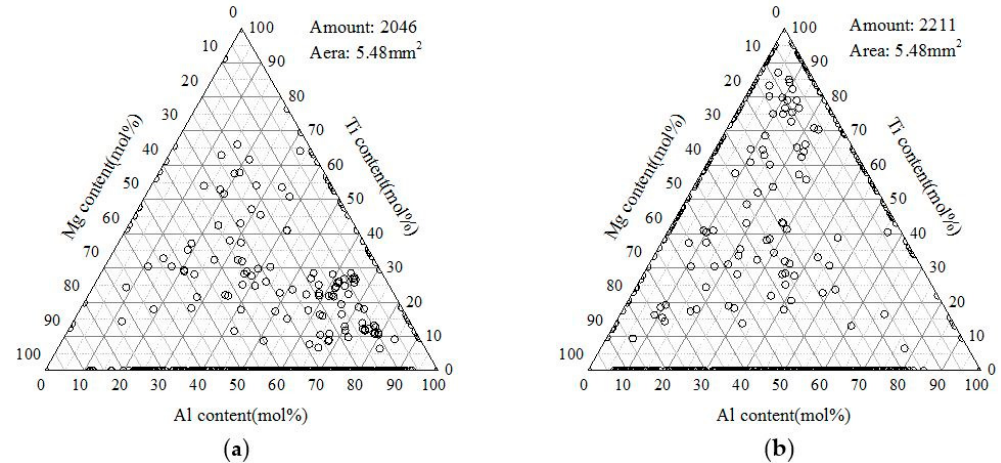
Figure 6. Chemical composition distributions of inclusions in all specimens: ( a ) Al–Ti–Mg; and ( b ) Al–Mg–Ti.